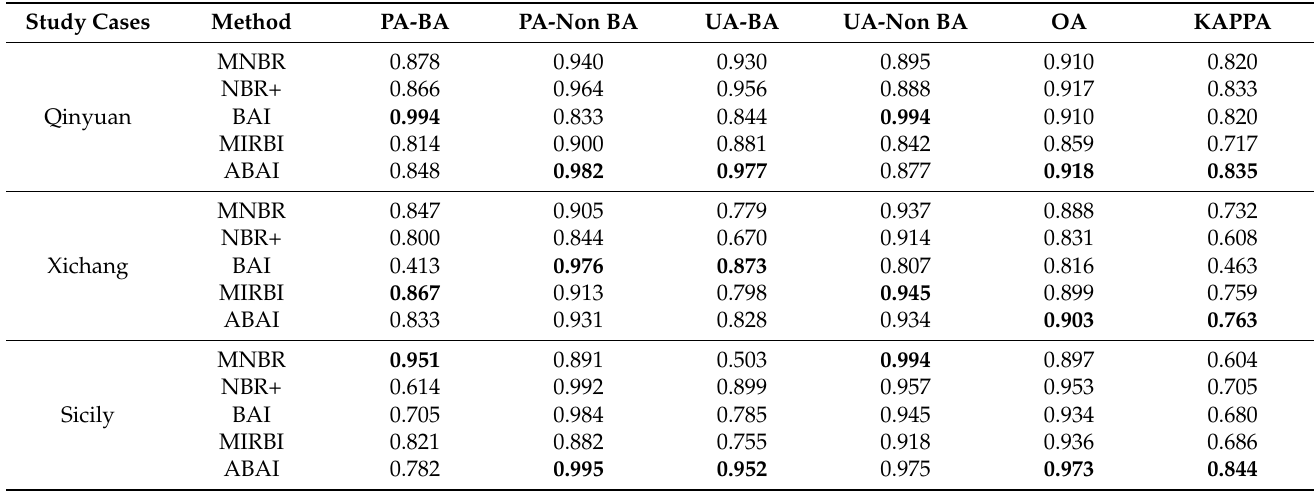
Table 5. Quantitative assessments and comparisons of the extraction accuracy for the different methods, where PA and UA represent the producer’s and user’s accuracy, respectively (Note values with the highest accuracy are highlighted in